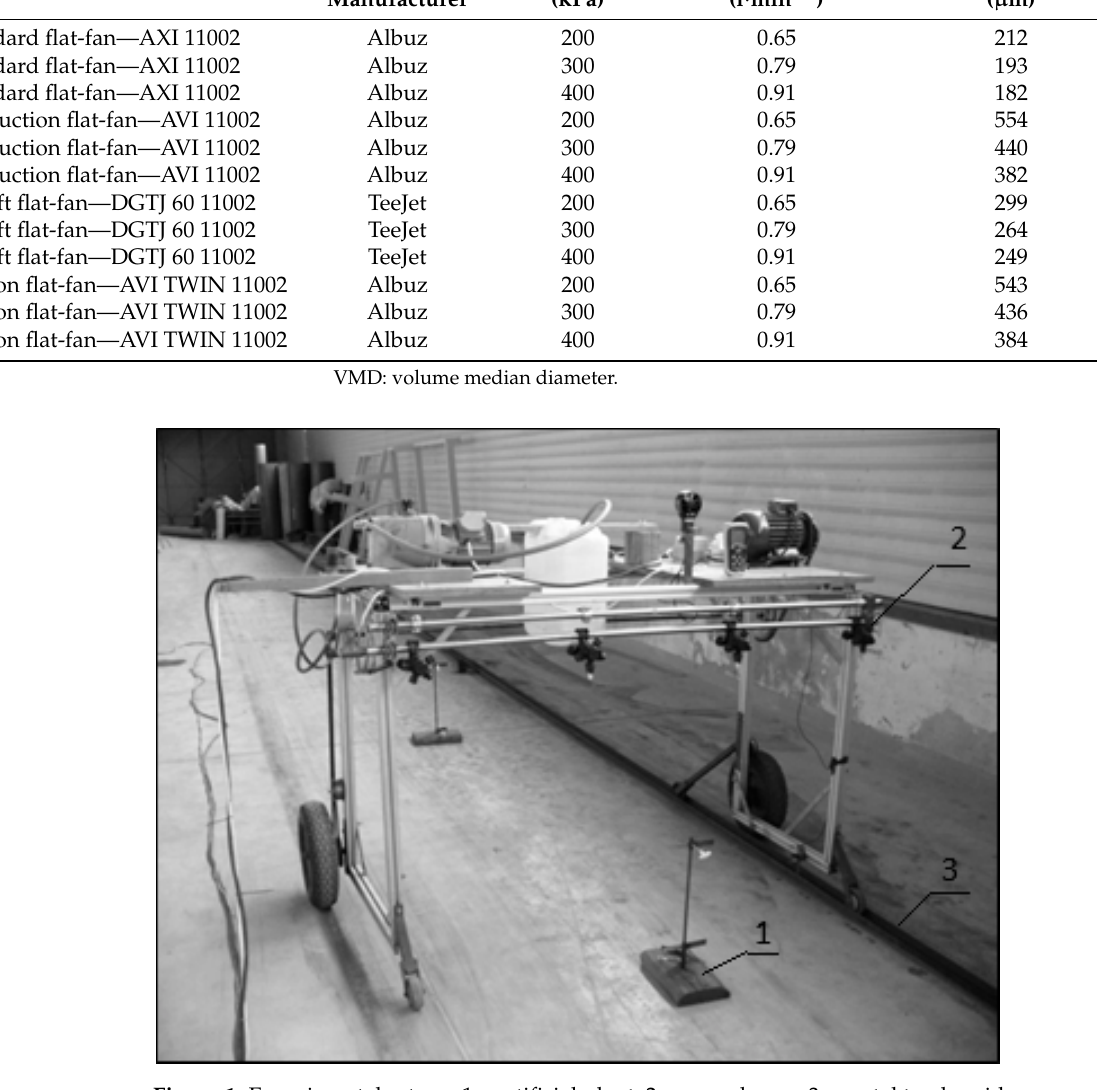
Figure 1. Experimental set-up: 1—artificial plant, 2—spray boom, 3—metal track guide. The degree of coverage was obtained based on a computer image analysis in Pho- toshop CC 2019 software. Water-sensitive papers change color from yellow to dark blue after contact with water, making it possible to analyze them. The dimensions of the water- sensitive papers are 26 mm × 76 mm, and three fragments with an area of 100 mm 2 were randomly selected for analysis. The degree of coverage was determined as the ratio of the surface covered with the liquid to the surface of the